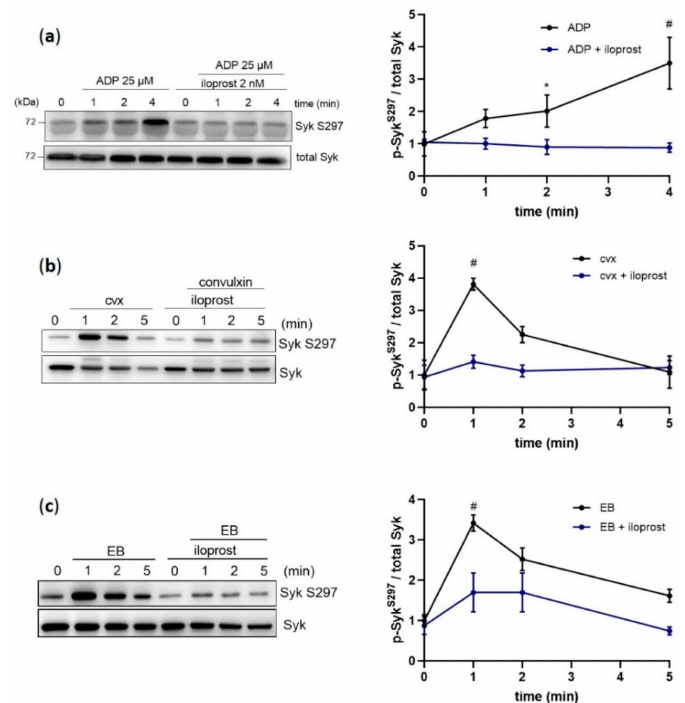
Figure 1. Platelet Syk S297 is upregulated by ADP, convulxin, and echicetin beads. Human washed platelets were pre-incubated with iloprost (2 nM; 3 min) at 37 ◦ C prior to stimulation with ( a ) 25 µ M ADP, ( b ) 50 ng / mL convulxin (cvx), or ( c ) 0.5% ( v / v ) echicetin beads (EB). Platelet aggregation was stopped after 1, 2, or 5 min of stimulation under stirring conditions by adding Laemmli bu ff er. Syk